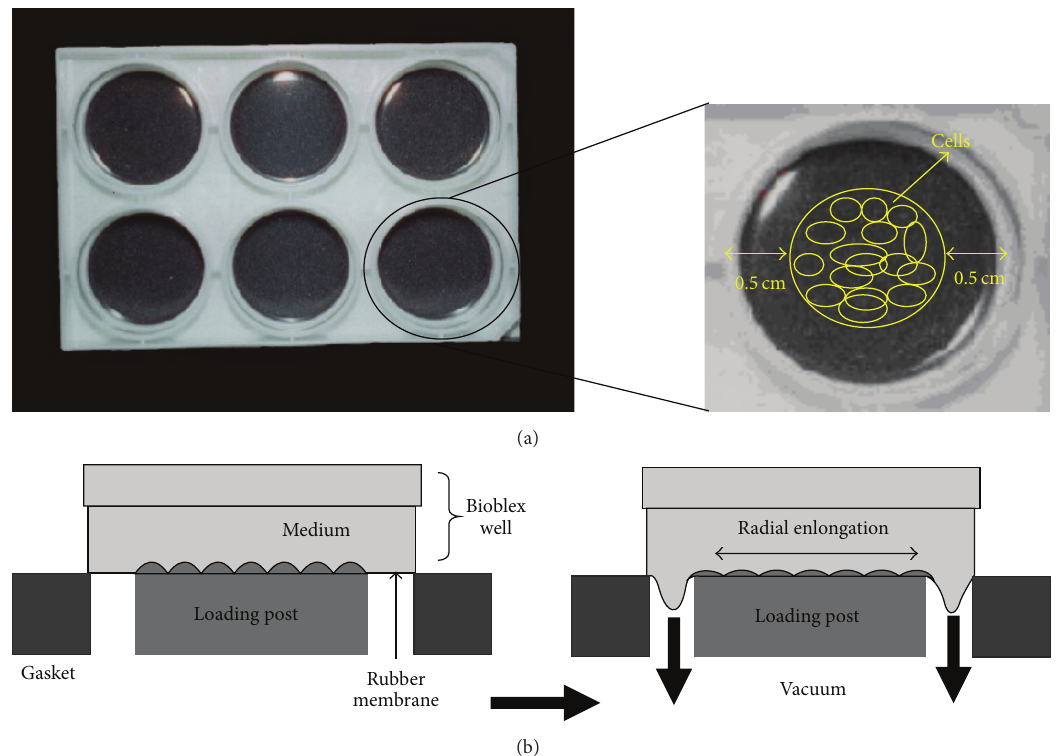
Figure 2: (a) Formation of cell sheet construct on Bioflex culture plate; (b) diagram of side view of radial stretch system.